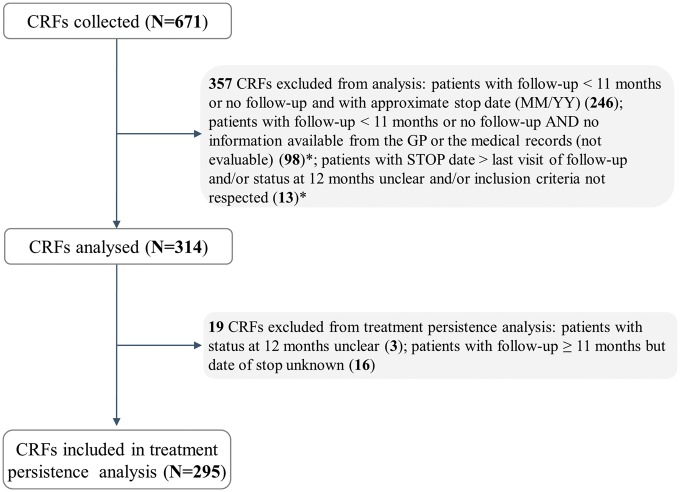
Patients’ flow chart. CRF, case report form; n, number of patients. Asterisk indicates no information available at 12 months, therefore the CRFs were excluded from the analysis.